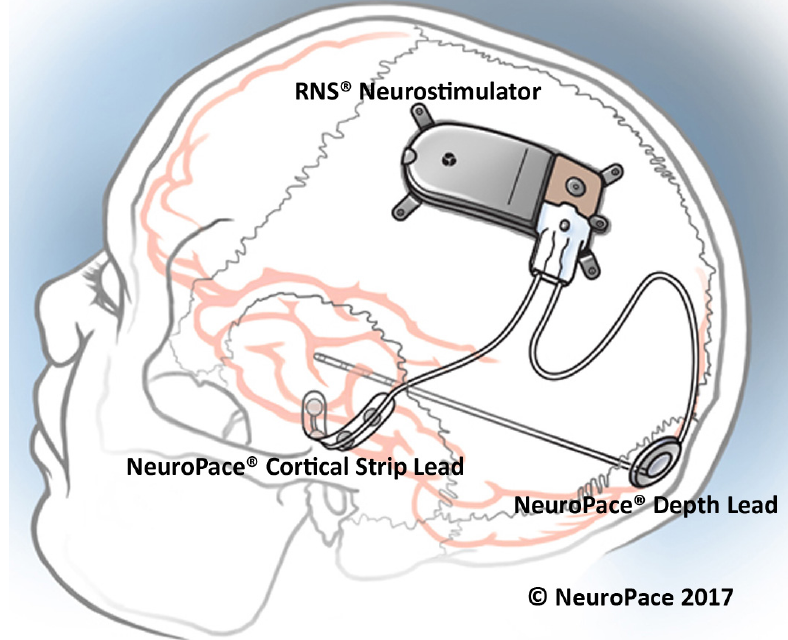
Figure 9. FDA approved responsive neurostimulation (RNS) system for closed-loop epilepsy detection and stimulation (courtesy of NeuroPace, Inc.)